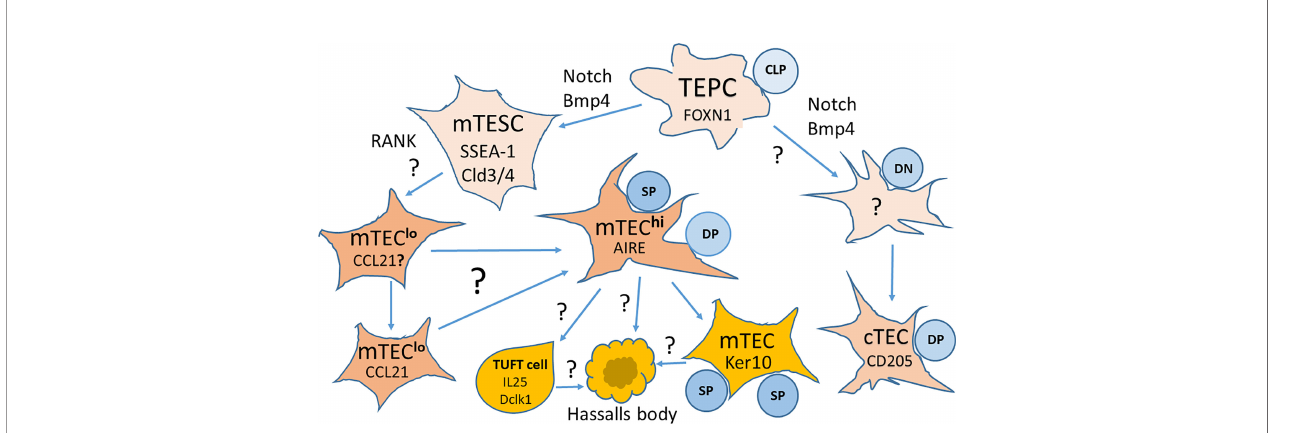
FIGURE 2 | Key markers and pathways in the development of thymic epithelial cells (TECs) from bipotent thymic epithelial progenitor cells (TEPCs). TEPCs differentiate into medullary and cortical thymic epithelial cell lineages (mTECs and cTECs, respectively) that are regulated by Foxn1 expression. mTEC development goes through an intermediate stem cell stage (mTESCs), expressing the stem cell marker SSEA-1, and requires Notch signaling for the formation of mature Aire expressing mTECs hi . Other pathways to the differentiation of mTEC subsets are still a matter of intensive research. It is also yet not known whether cTEC development goes through a similar intermediate stage. CLP, Committed Lymphocyte Precursor; DN, Double Negative Thymocytes; DP, Double Positive Thymocytes; SP, Single Positive Thymocytes. Modi fi ed from Alawam et al., 2020 (71); the article is distributed under the terms of the Creative Commons Attribution License (CC